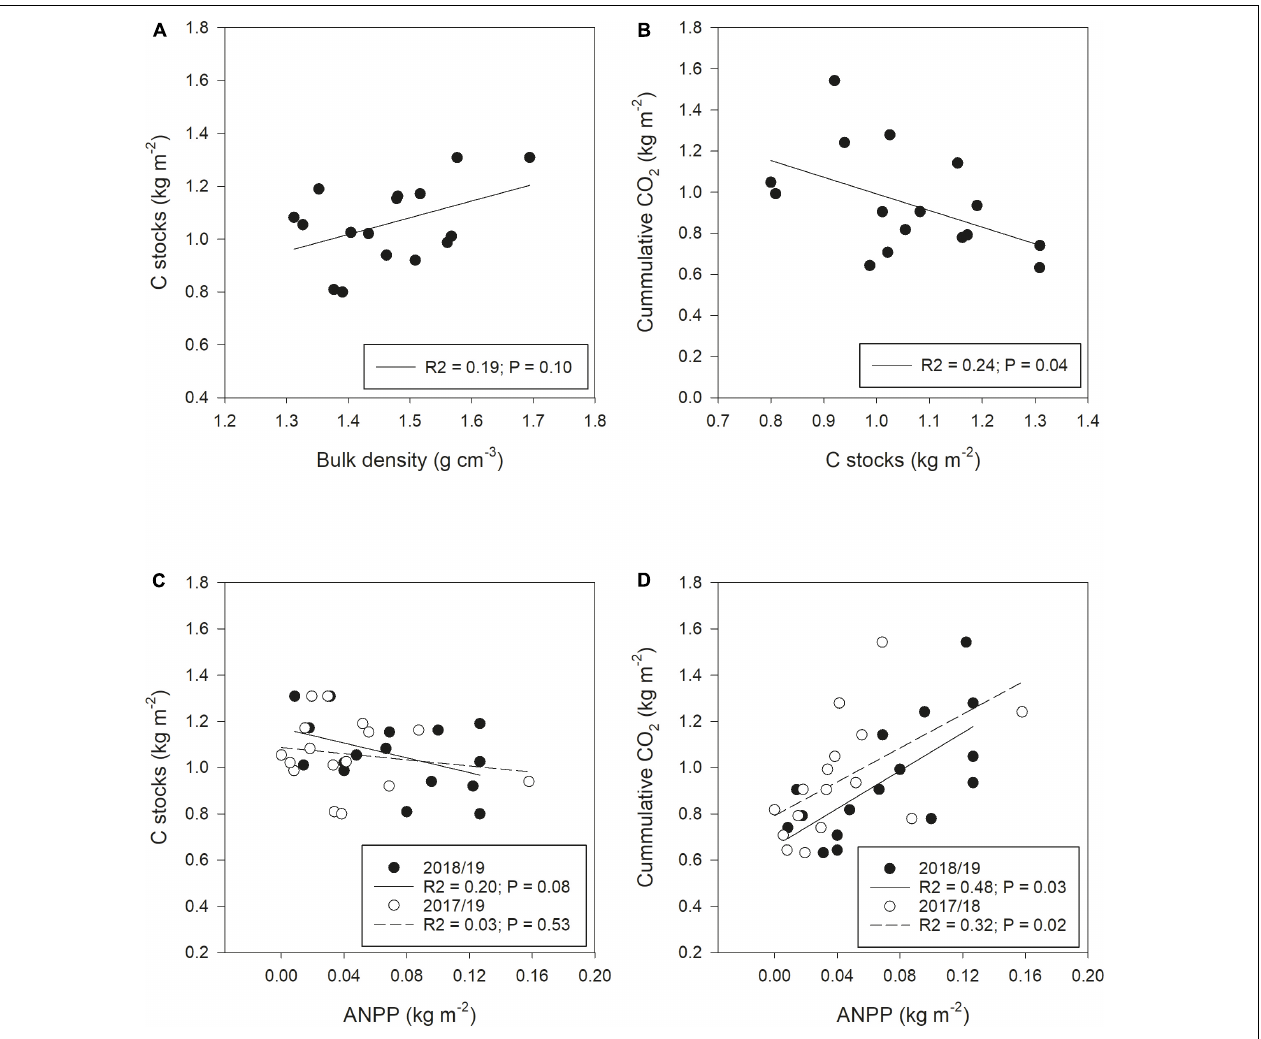
FIGURE 6 | Dependence of carbon stocks and CO 2 fluxes on environmental variables (A,C,D) and on each other (B) . (A) Carbon stocks in dependence of bulk density; (B) CO 2 fluxes in dependence of C stocks; (C) carbon stocks in dependence of aboveground net primary production (ANPP), and (D) CO 2 fluxes in dependence of ANPP. For ANPP, open circles indicate data from the 2017/18 growth period, while shaded circles represent data from the 2018/19 period, i.e., the same growth period for which CO 2 flux and carbon stocks were assessed. Dashed lines on panels C and D represent regression lines for 2017/18 while solid lines represent regression for 2018/19.